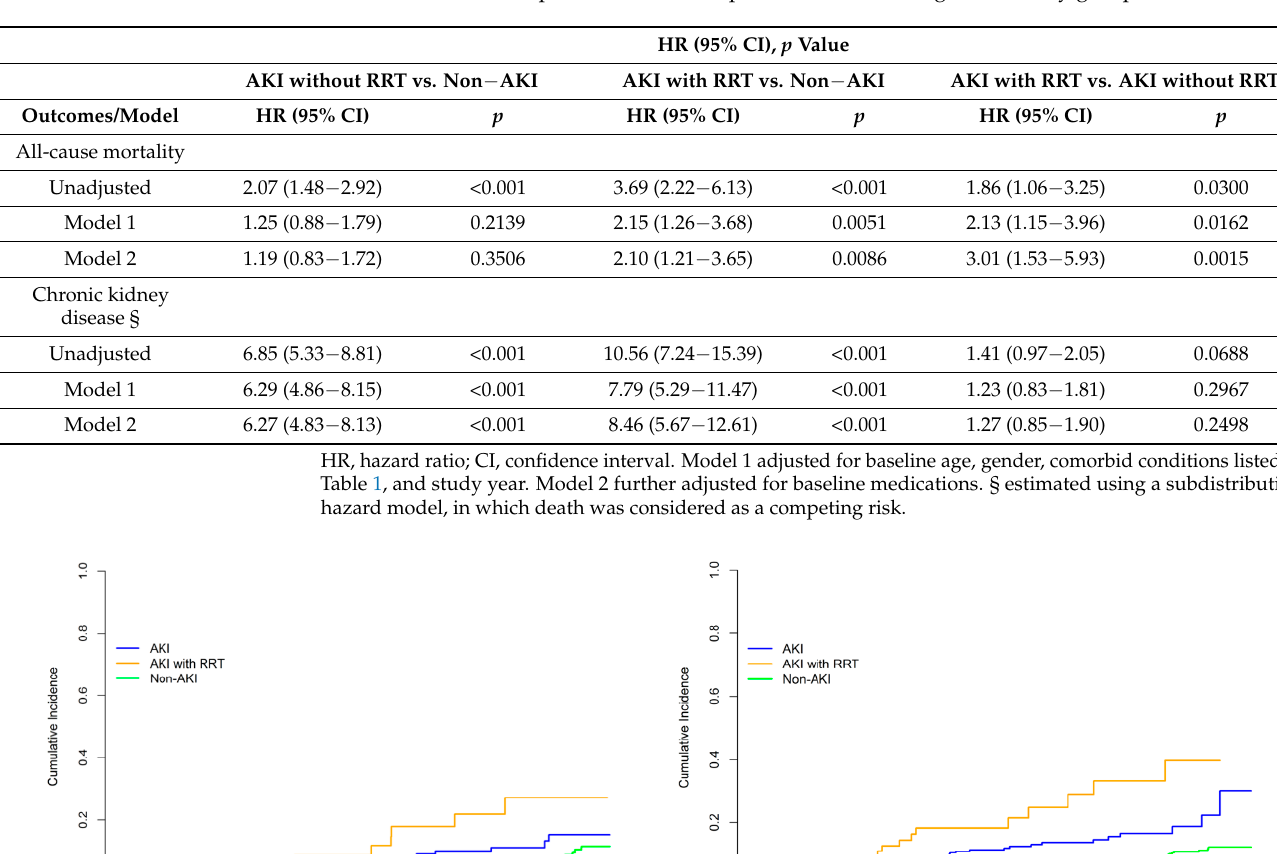
Table 3. Pairwise comparison of follow-up outcomes according to the study groups.